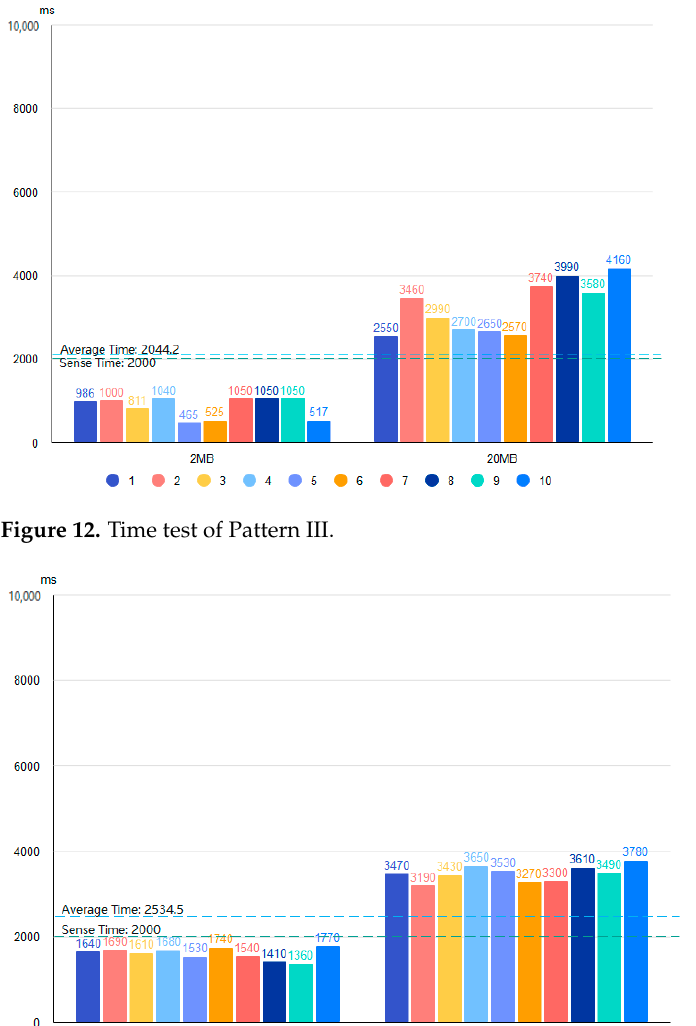
Figure 11. Time test of Pattern II.